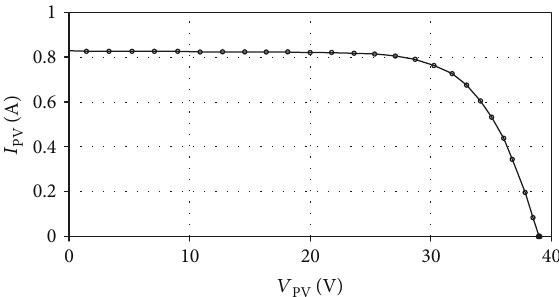
Figure 3: I - V characteristic of the two series-connected PVUs. 26 September 2017, Aversa (CE), Italy. S = 600 W/m 2 and ambient temperature T amb = 25 ° C .